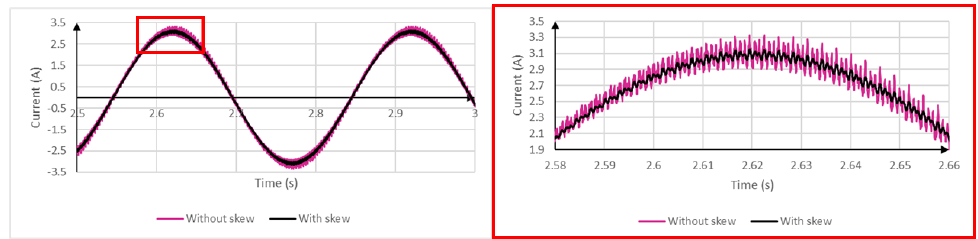
Figure A1. Rotor current with and without added rotor skewing effect, enlarged on right side.